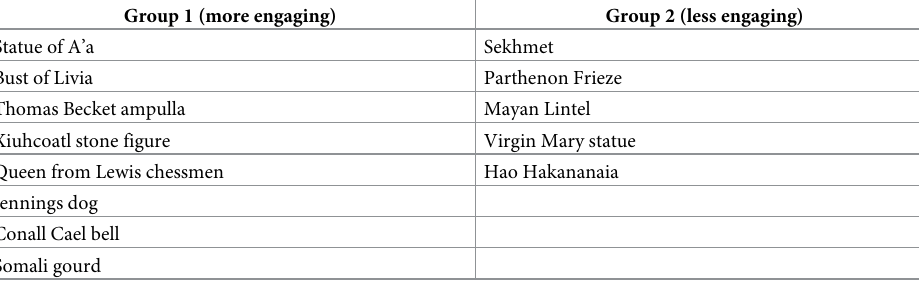
Table 3. Groups of objects identified by engagement level.